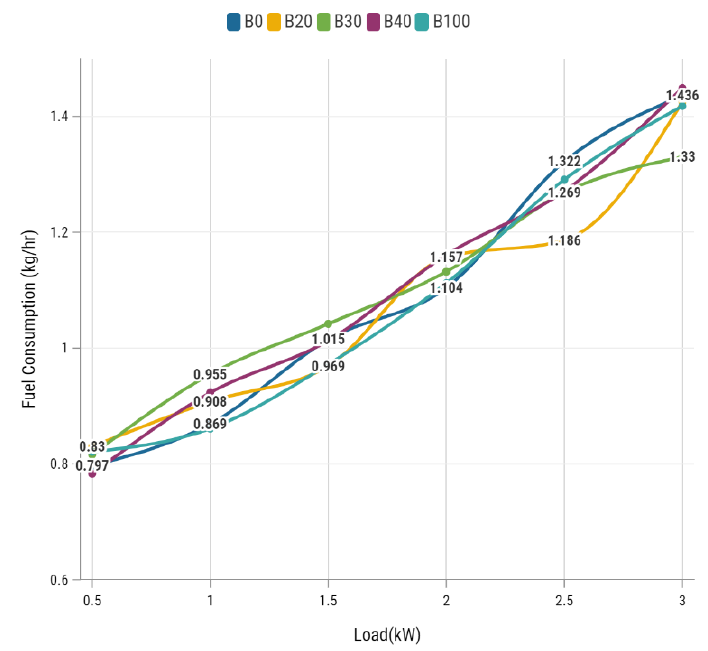
Figure 6. Comparison of fuel consumption at different loads.